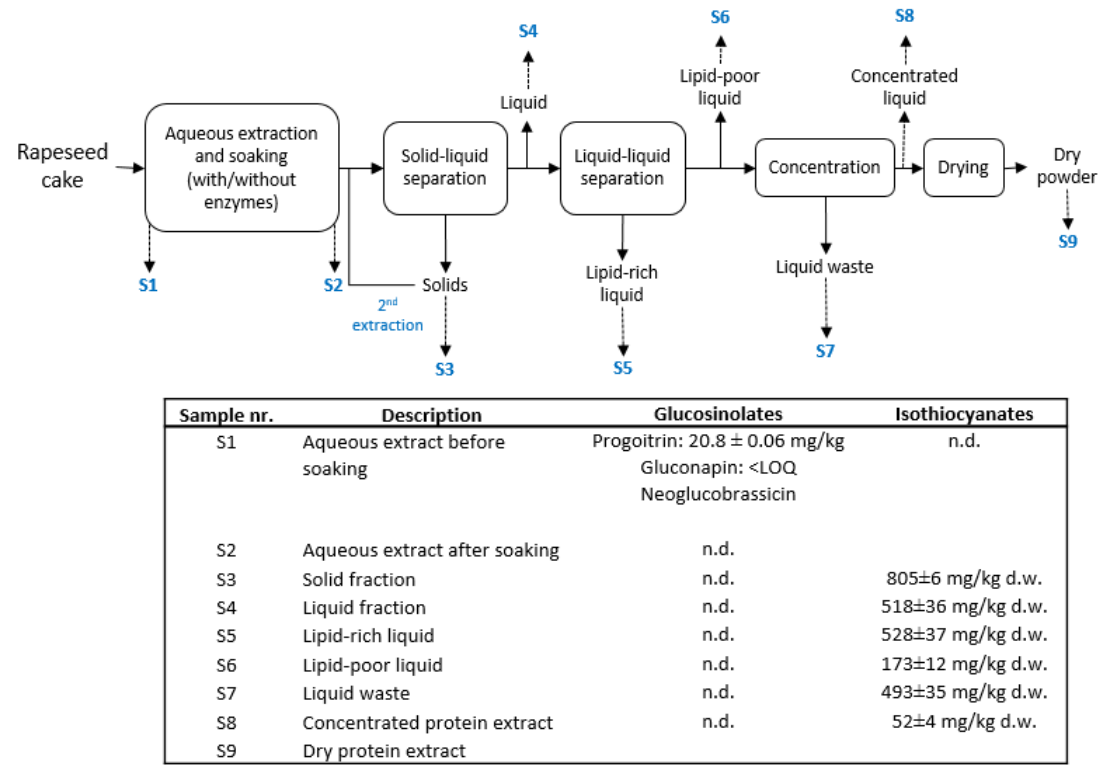
Figure 1. Glucosinolates and goitrin determined at different stages of pilot-scale protein extraction from cold-pressed rapeseed cake (CPR) during trial CPR-1. * n.d. — not detected.